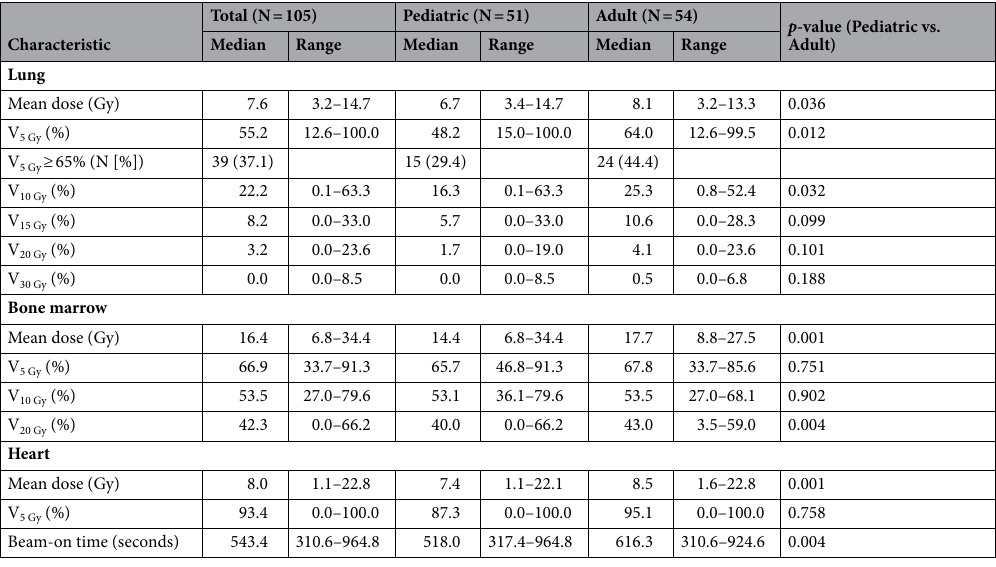
Table 5. Comparison of dosimetric characteristics between pediatric and adult patients. Gy, gray; V X Gy , volume of organs at risk of receiving more radiation than X